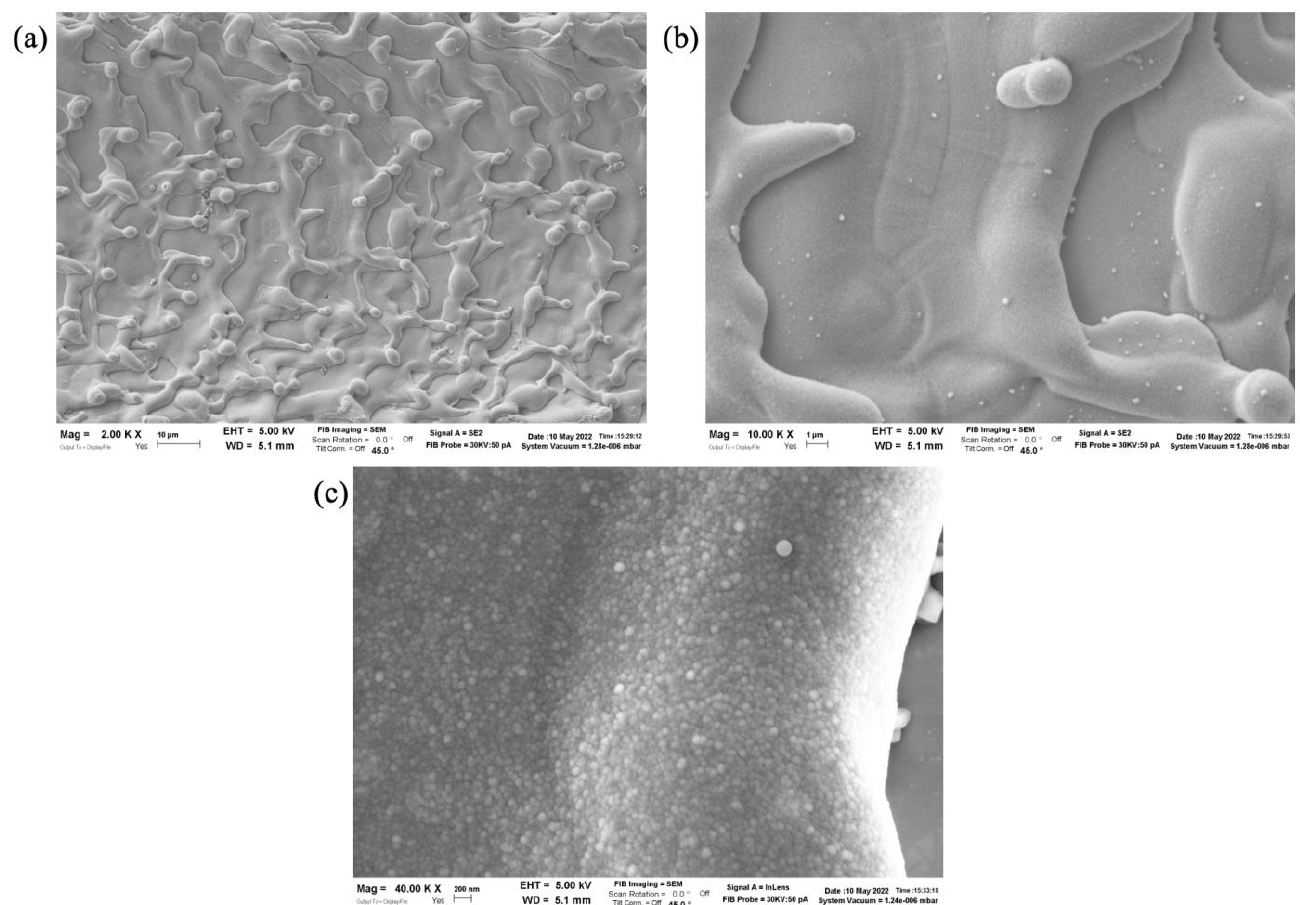
Figure 13. SEM images at ( a ) 2000×, ( b ) 10,000×, and ( c ) 40,000× of surfaces obtained with parallel lines scanning strategy at 12 W: Surf 3 sample (laser texturing + sol – gel (APTES + PE interlayer)).